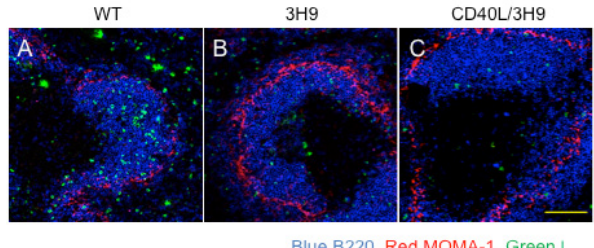
Figure 2. Excess CD40L does not reverse follicular exclusion of anergic anti-DNA B cells in 3H9 mice. Sections of spleen from 11- to 34-wk-old wild type (WT) ( A ), 3H9 ( B ), and CD40L/3H9 ( C ) mice were stained for MOMA-1, a marker for a subset of splenic macrophages (red), B220, a B cell marker (blue), Ig λ L chain (green), and analyzed by confocal microscopy. Ig λ + B cells in 3H9 mice are DNA-reactive. B cells positive for B220 are located in the follicles, and MOMA-1 + macrophages are located at the outer part of the follicles. T cell zone and red pulp are located inside and outside of the follicles, respectively. Representative data from four independent experiments. Four mice in each group were analyzed. Original magnifications, 20X. Scale bar (yellow line): 100